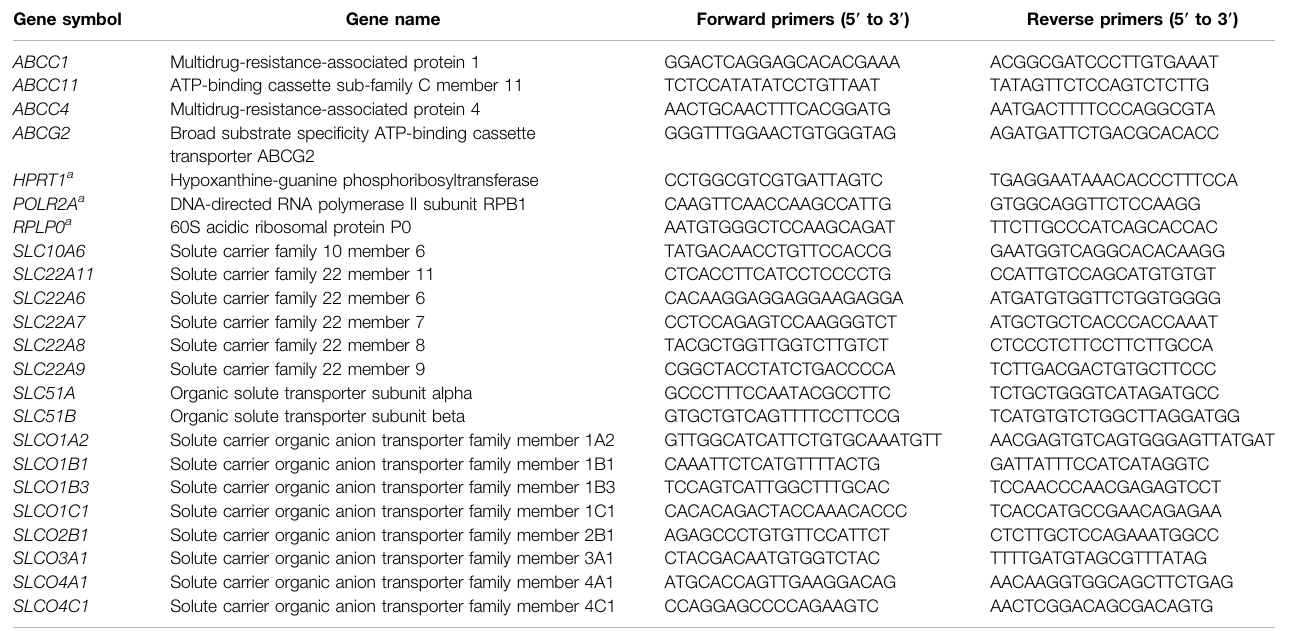
TABLE 3 | Sequences of the primers for SYBR green evaluation of gene